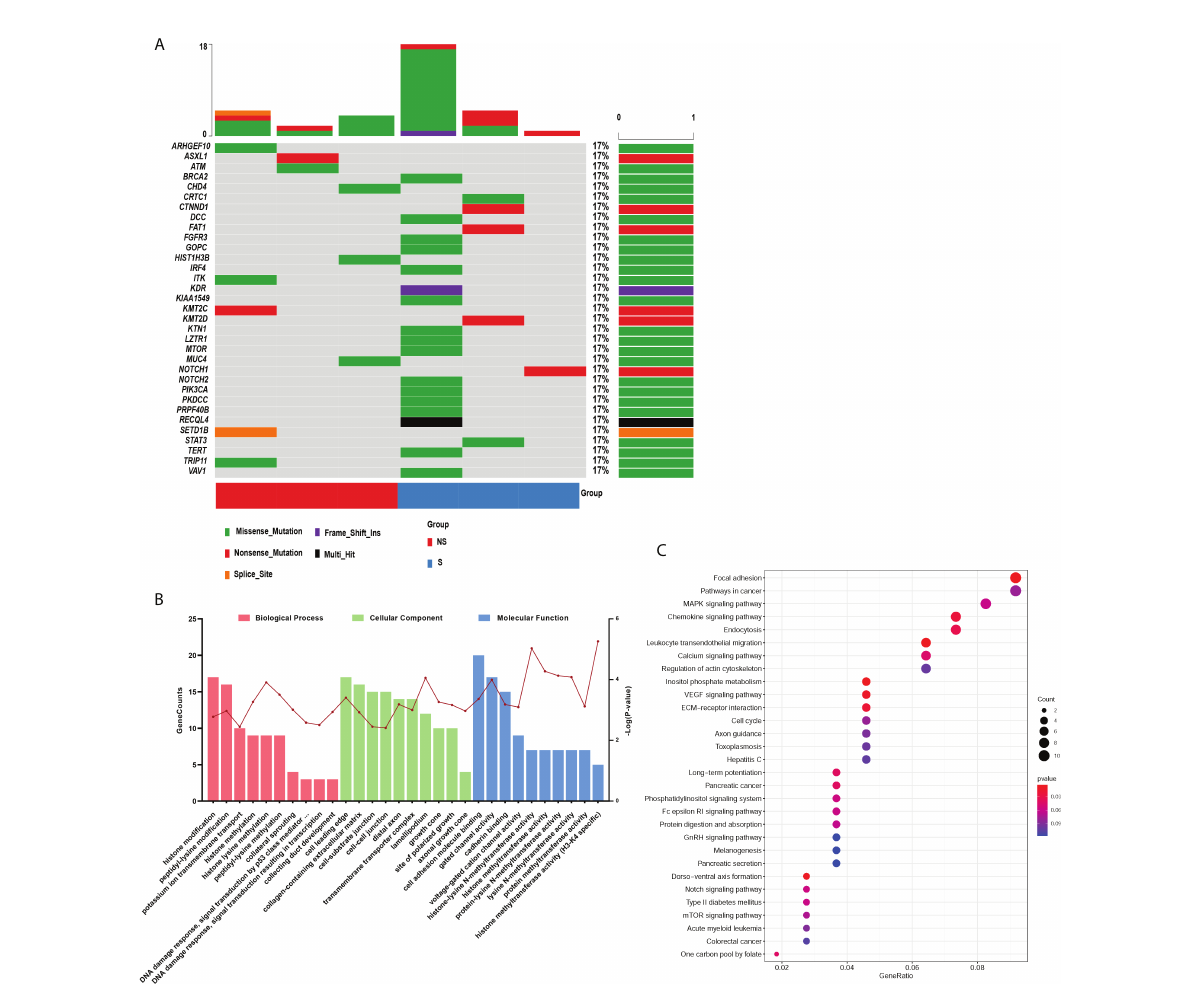
FIGURE 2 Functional analysis of somatic differentially mutated genes. (A) The oncoprint plot of 33 somatic mutations. (B, C) GO (B) and KEGG (C) enrichment analysis were performed on the differential mutant genes. Group S means the radiosensitive group and group NS means the radioresistant